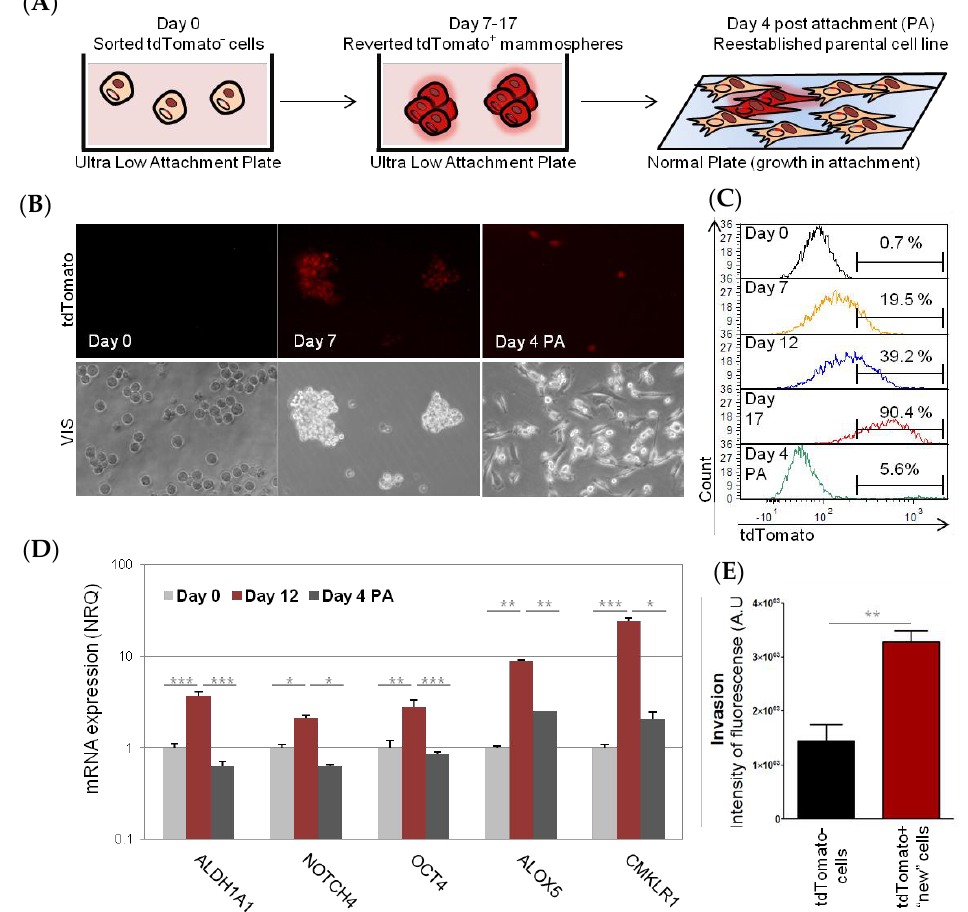
Figure3. MDA-MB-231reversionprocess. Schematicrepresentationoftheexperiment. Briefly, tdTomato −